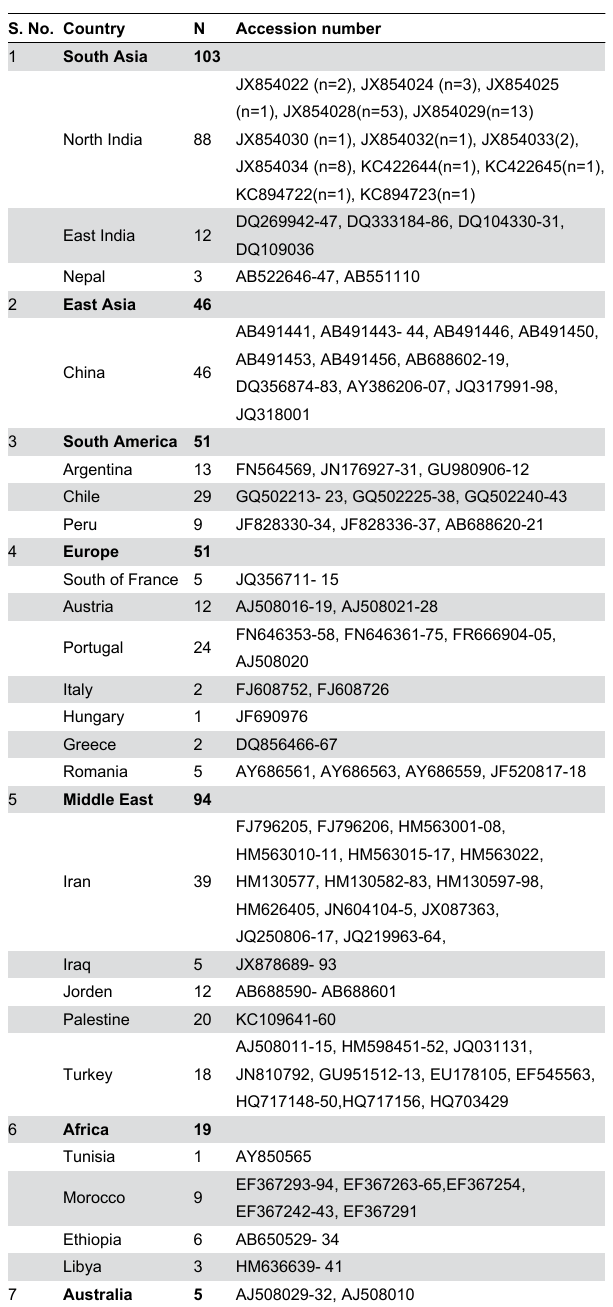
Table 1. Accession numbers of nucleotide sequenced of cox1 gene of Echinococcus granulosus sensu stricto from different